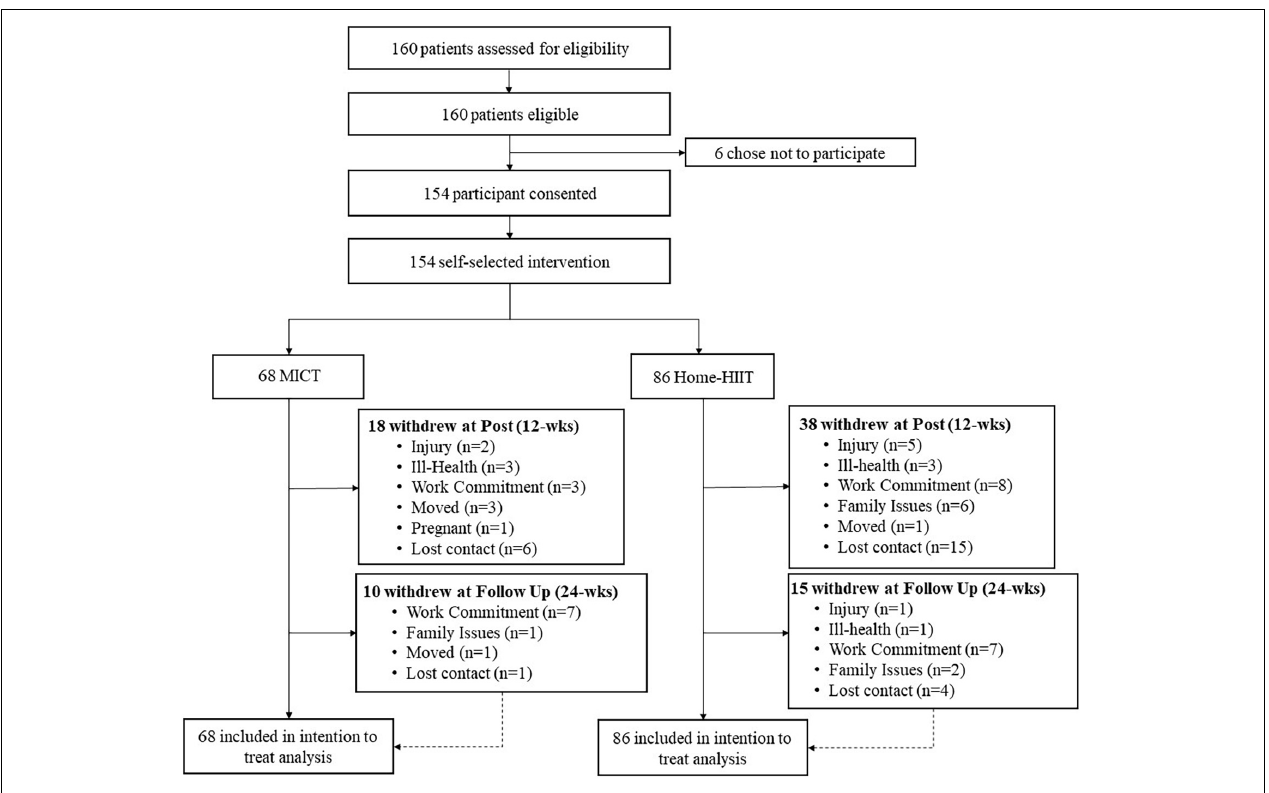
FIGURE 1 | Trial profile